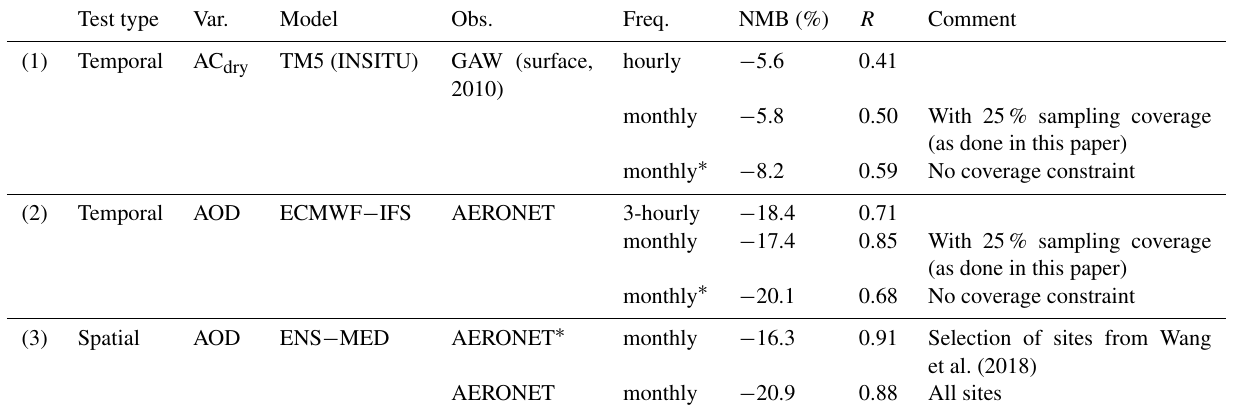
Table 5. Results from sensitivity studies related to spatio-temporal representation errors. AERONET ∗ indicates that two different site selec- tion schemes were used (see text in Sect. 4.5 for